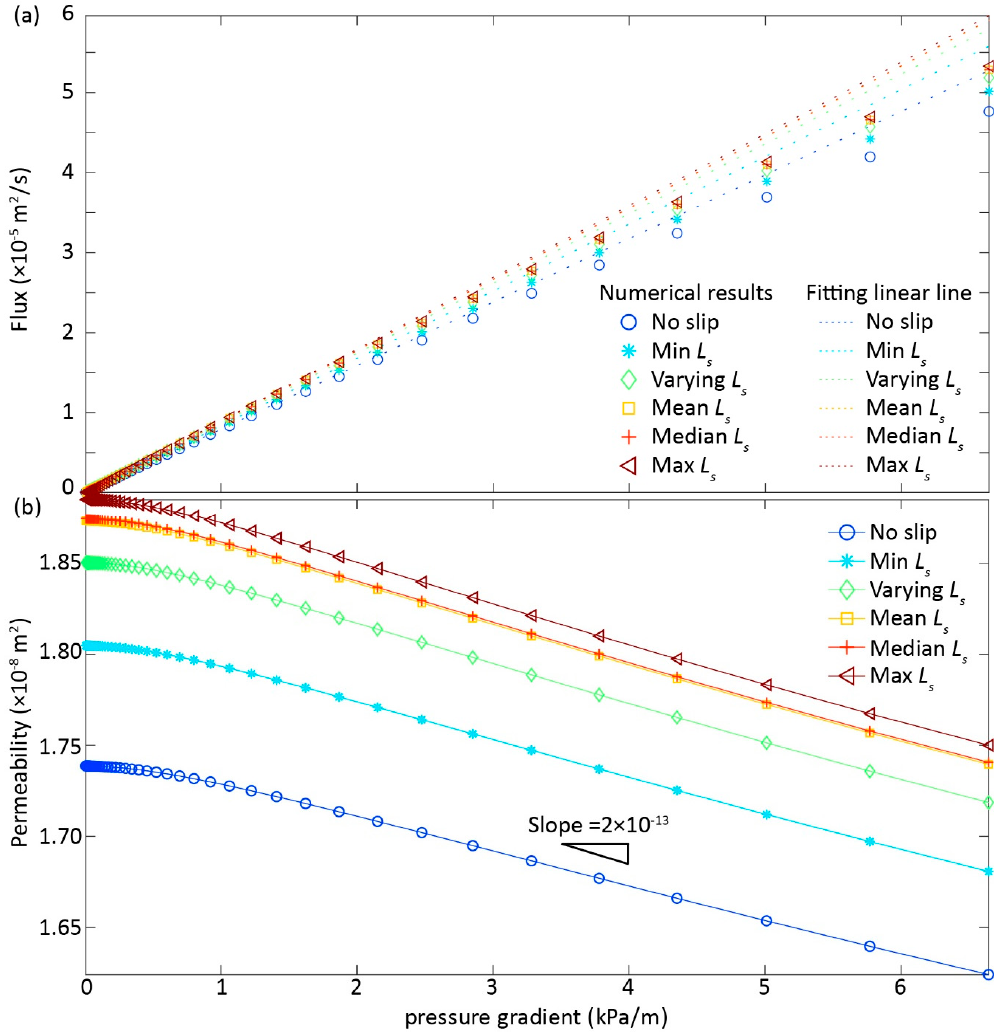
Figure 2. The relationships of flux ( a ) and permeability ( b ) with pressure gradient for six cases with a variety of slip lengths L s : case 1—no slip length with L s equal to 0; case 2—minimum L s assigned in the case 3; case 3—varying L s depending on aperture based on [20,21]; case 4—mean L s assigned in the case 3; case 5—median L s assigned in the case 3; and, case 6—maximum L s assigned in the case 3. In ( a ), the dashed-lines represent the linear fitting curves to the numerical-derived results (symbols). In ( b ), the slope value was estimated by dividing the fracture permeability by pressure gradient.